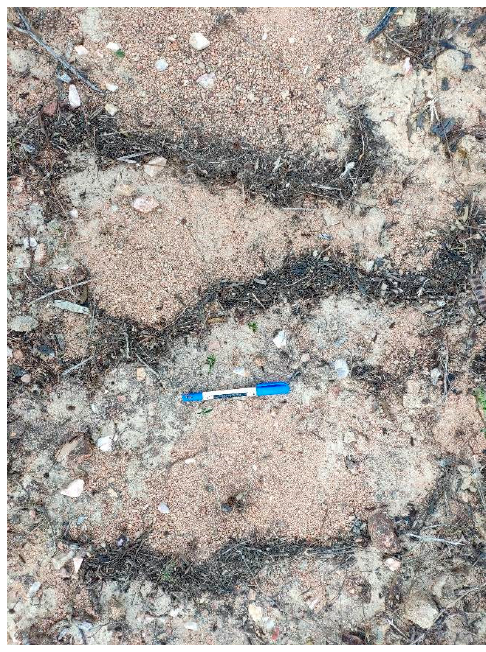
Figure 5. Photograph detailing the soil surface after a rainfall event (plot with mulch cover).